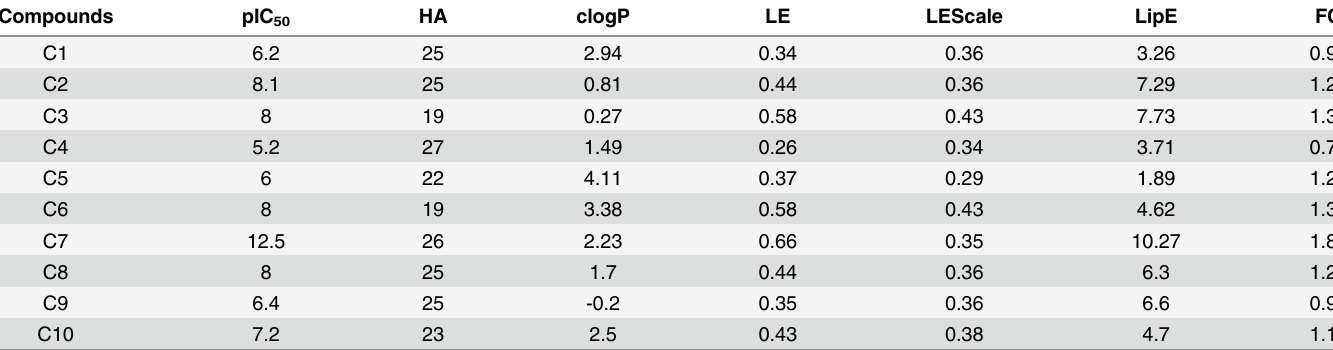
Table 4. Ligand efficiency (LE), Lipophilic Efficiency (LipE) and Fit Quality (FQ) values of C1-C10 hits. Compounds